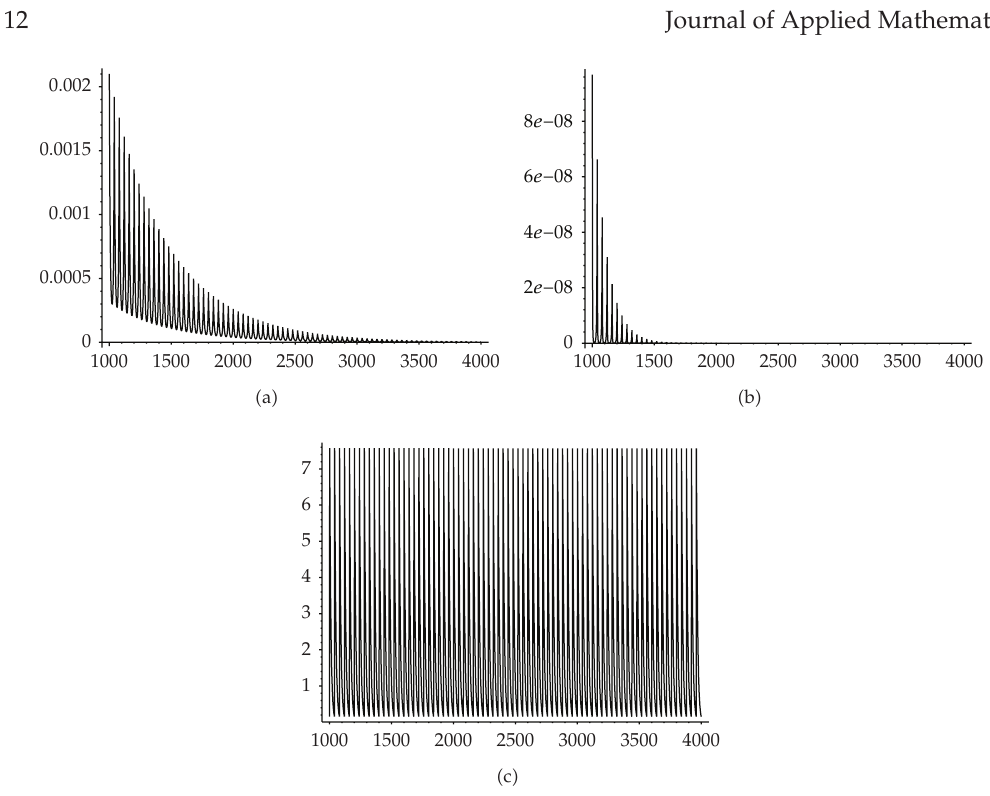
Figure 1: Dynamic behavior of system (cid:5) 1.1 (cid:6) . When p > p max (cid:7) 8.15, the cyanobacteria and green algae will become extinct. Time series evolving according to biological control system (cid:5) 1.1 (cid:6) : (cid:5) a (cid:6) the cyanobacteria population x , (cid:5) b (cid:6) the green algae population y , and (cid:5) c (cid:6) the fish population z